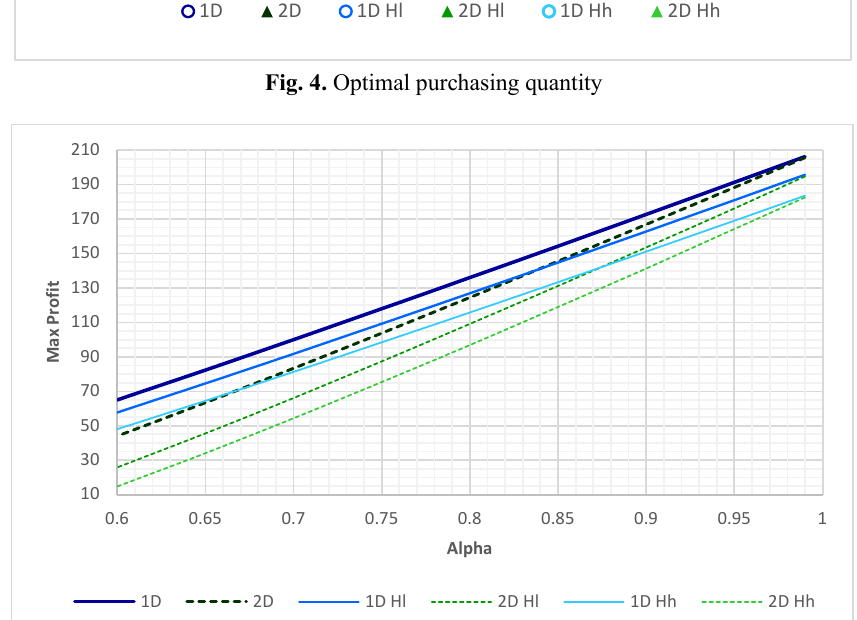
Fig. 5. Maximum expected